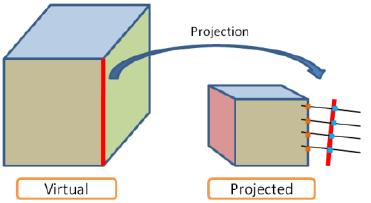
Figure 8. The edge is projected and ME looks for strong gradient points (orange) in a line perpendicular to the edge that passes through the sampled point